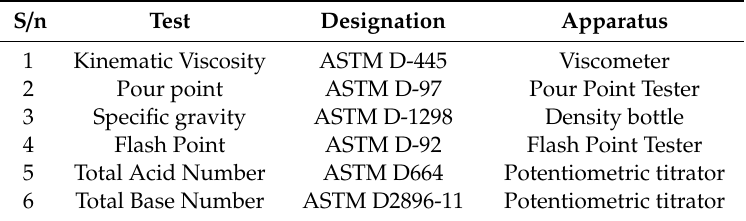
Table 1. Standard lubricating oil testing